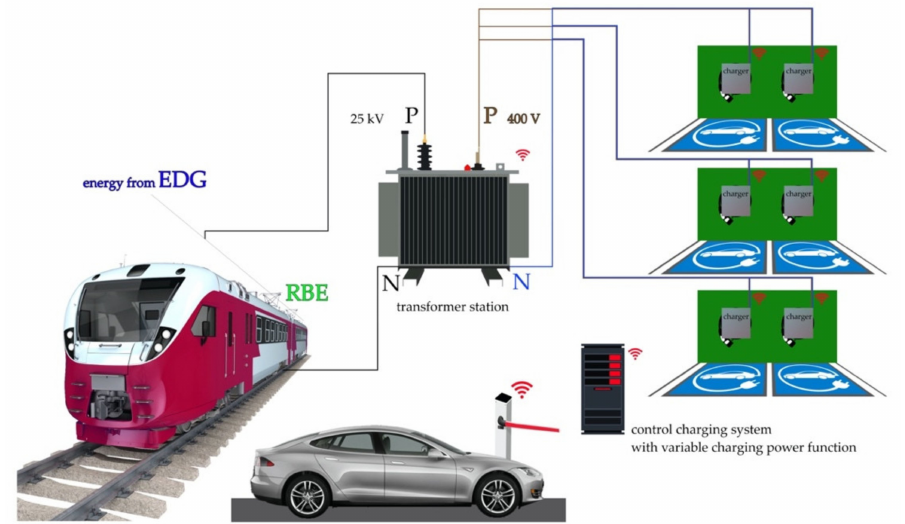
Figure 1. Car park model equipped with single-phase chargers and variable charging power